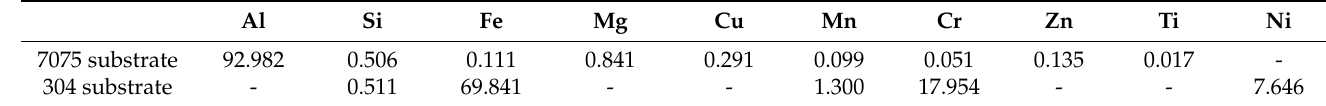
Table 2. Composition (Avg. wt. %) of 304 and 7075